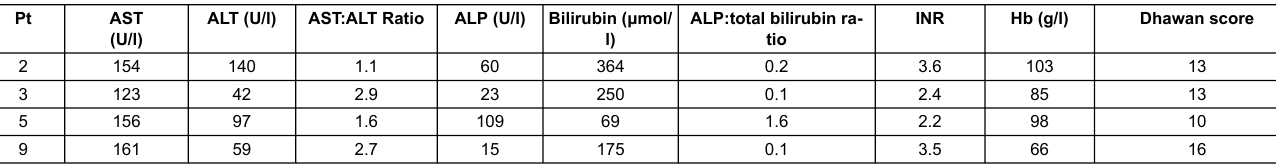
incomplete diagnostic datasets. Table 2: Laboratory results for patients with acute liver